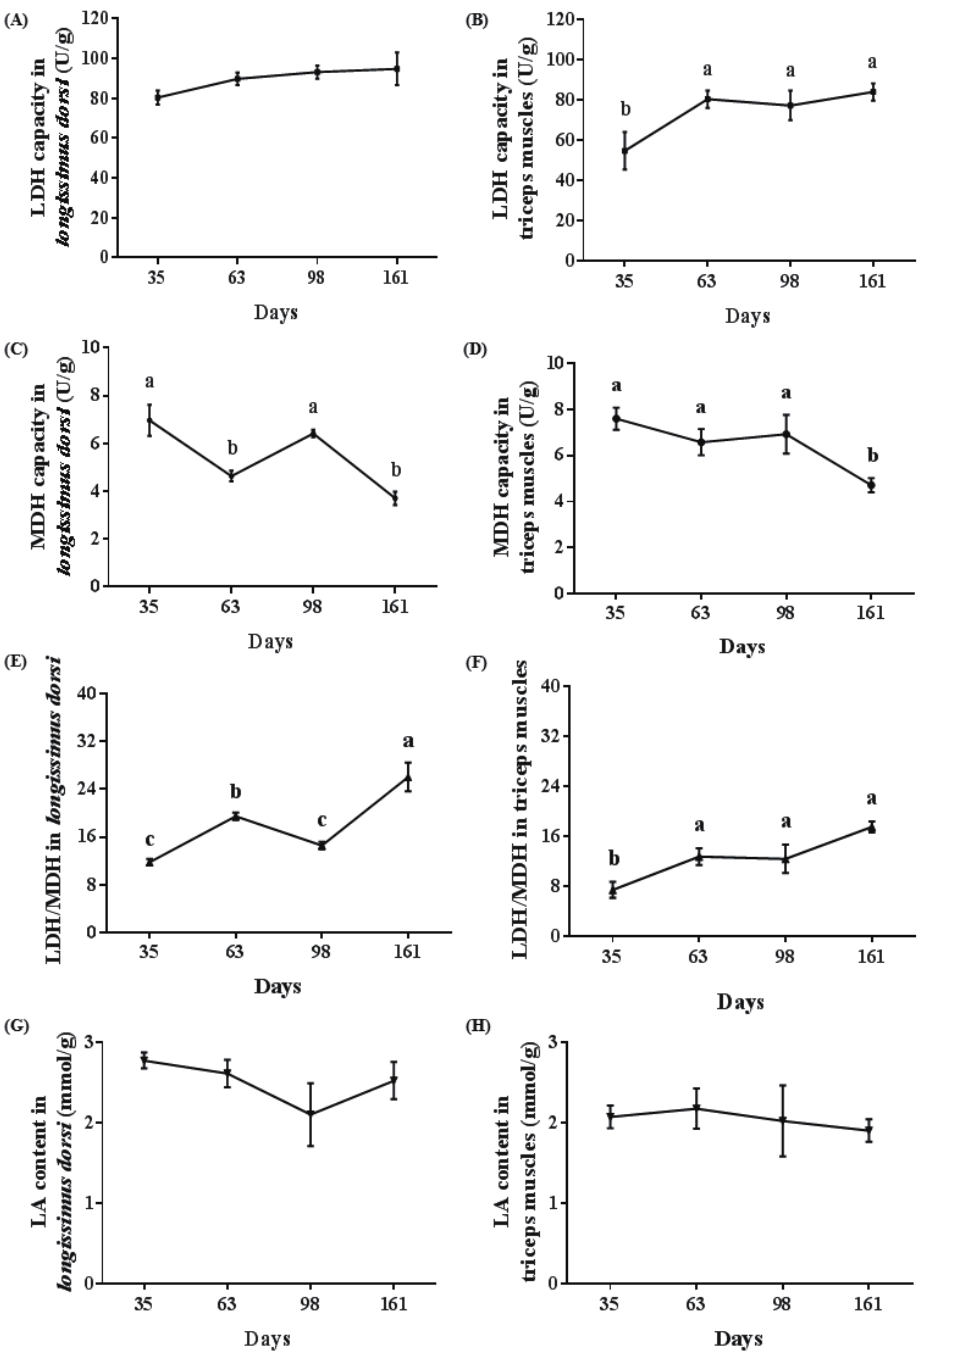
Figure 3. Changes of enzyme activities and lactic acid (LA) of porcine skeletal muscle at different stages of growth. (A, B) Proportion of lactic dehydrogenase (LDH) in longissimus dorsi and triceps muscles, respectively. (C, D) Proportion of MDH in longissimus dorsi and triceps muscles, respectively. (E, F) The ratio of LDH/MDH in longissimus dorsi and triceps muscles, respectively. (G, H) LA content in longissimus dorsi and triceps muscles, respectively. Mean with different superscripts demonstrate significant difference among groups (p<0.05), n =